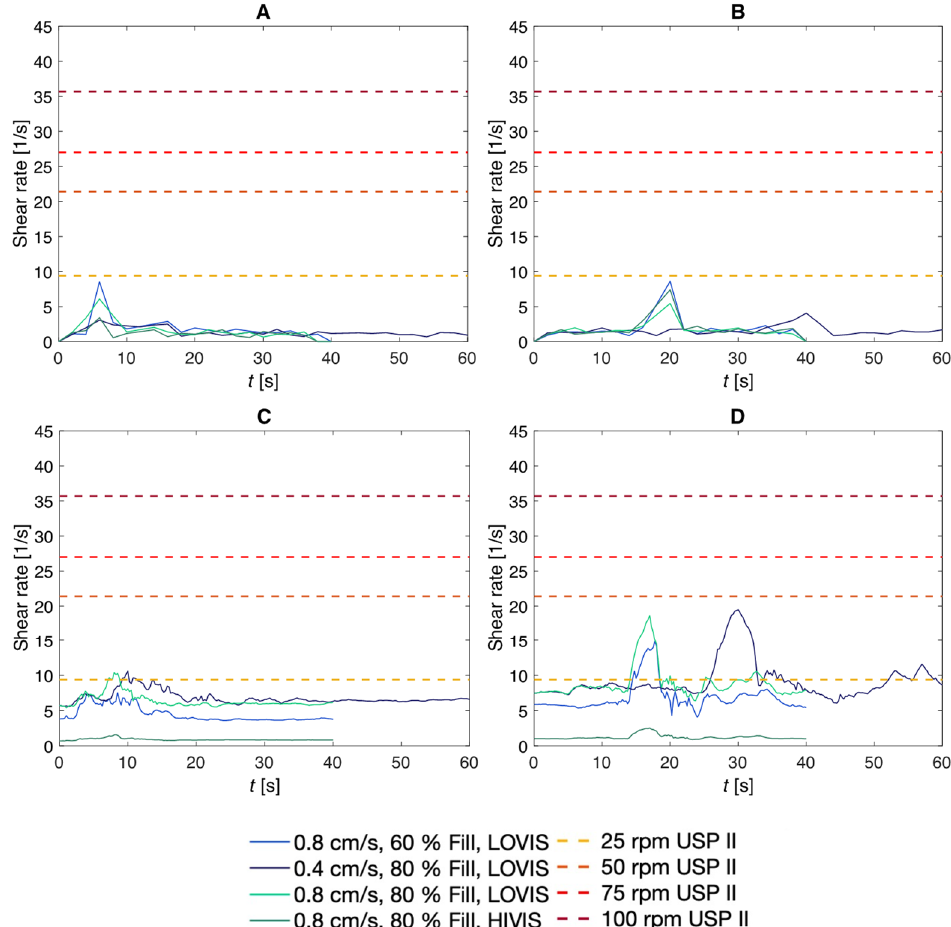
Figure 13. Average shear rates versus maximum shear rates for each parameter combination, where ( A ) represents DCM ‘segment 2’, ( B ) DCM ‘segment 6’, ( C ) DCMDT ‘segment 2’, and ( D ) DCMDT ‘segment 6’. USPII shear rate data was reproduced from [50], Elsevier,